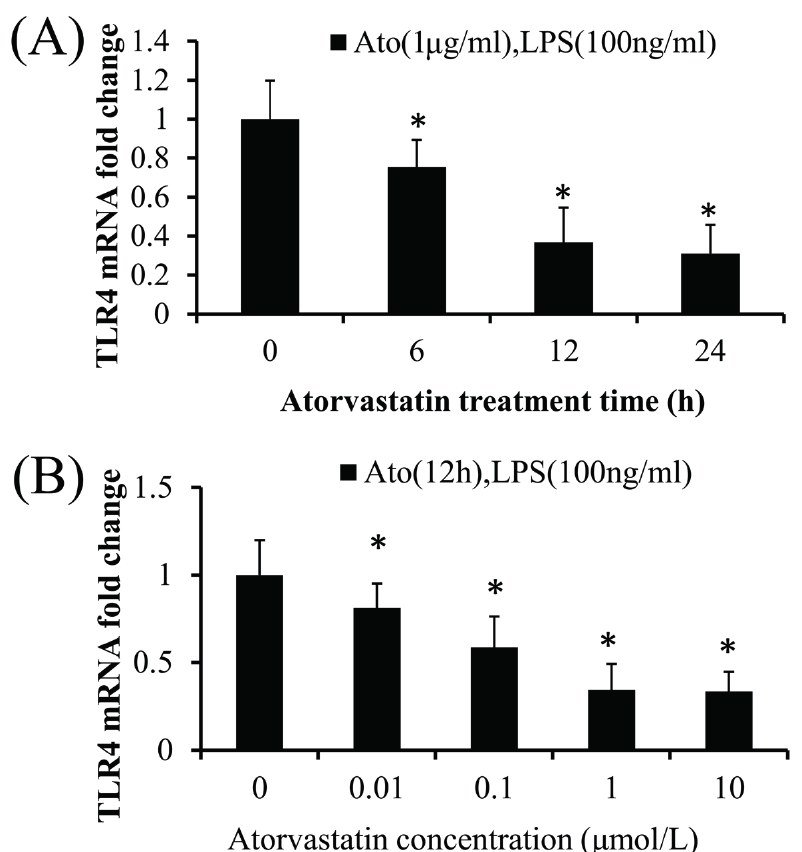
FIGURE 2 - TLR4 mRNA expression in HCAECs after atorvastatin pretreatment. (A) Dose ef fect response showing TLR4 mRNA reduction treatment in HCAECs. Statistical analysis was performed on 6h, 12h, and 24h versus 0h group, respectively. (B) Time-effect response showing TLR4 mRNA reduction after atorvastatin treatment in HCAECs. Statistical analysis was performed on 0.01µmol/L, 0.1µmol/L, 1µmol/L and 10µmol/L versus 0µmol/L group, respectively.*P<0.05 indicates significant